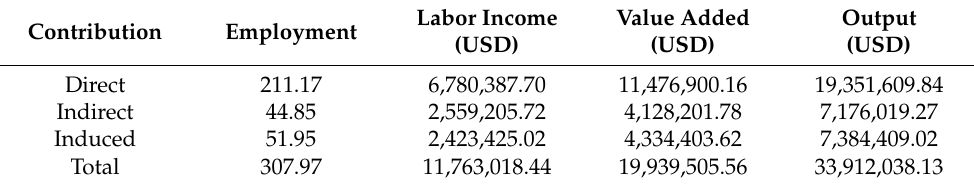
Table A5. Contribution of Partner Visitor Spending to Duval, Flagler, and St. Johns Counties (Annual). Contribution